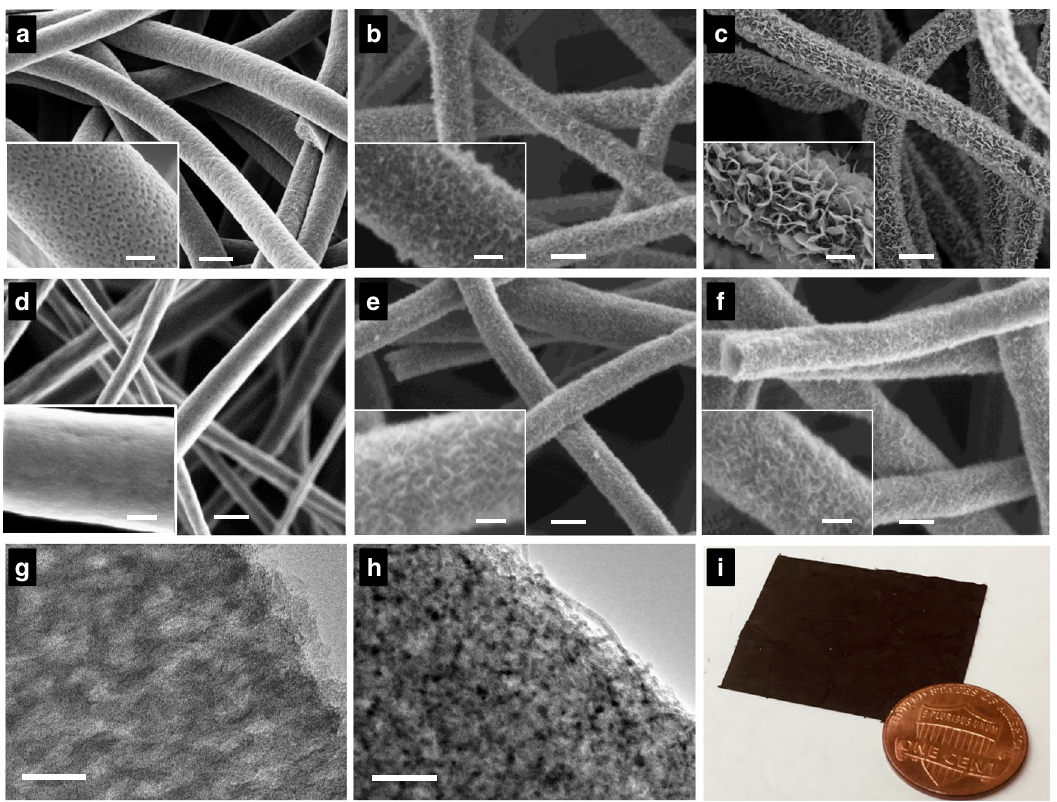
Fig. 2 Morphology characterizations. a – f SEM images of ( a ) PCF, ( b ) PCF@MnO 2 -1h, ( c ) PCF@MnO 2 -2h, ( d ) conventional CF, ( e ) CF@MnO 2 -1h, and ( f ) CF@MnO 2 -2h. Scale bars: 200 nm. (Insets) Magni fi ed views of the single fi bers. Scale bars: 50 nm. Due to the surface effect, the interconnected mesopores in PCFs appear as discrete dark spots on the fi ber skin (inset a) but are absent in the conventional CFs (inset d ). g , h TEM images of PCF ( g ) before and ( h ) after loading MnO 2 for 2 h. Scale bars: 50 nm. The MnO 2 nanosheets are removed from the fi ber skin to reveal the internal structures without interference. g The gray and dark areas correspond to the interconnected mesopores and the carbon matrix, respectively. h MnO 2 appear darker than carbon due to the higher atomic number. i A photograph of a piece of PCF@MnO 2 -2h electrode next to a U.S. penny with a diameter of ~1.9